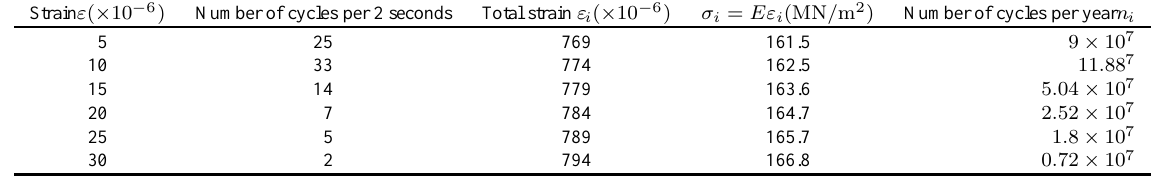
Table 3 The statistics of σ i and n i for fatigue strength of the piston rod in stochastic